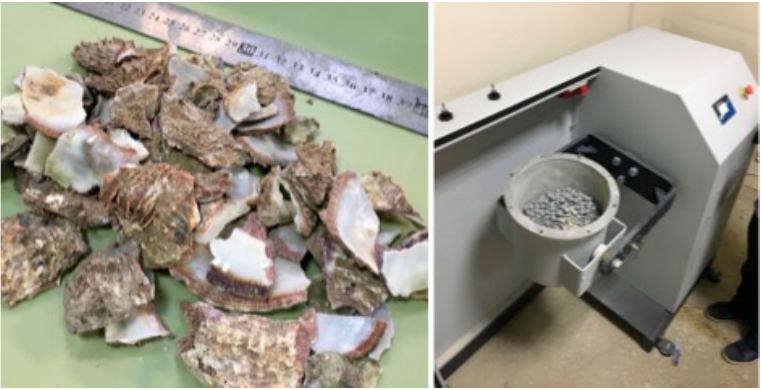
Figure 1. Photo of the waste seashells and grinding mill used. The cement, LF, MK, and seashell chemical and physical properties are summarized in Table 1, while their particle size distribution curves determined using a laser diffraction analyzer are plotted in Figure 2. As shown, the MK is essentially composed of SiO 2 and Al 2 O 3 compounds (i.e., 55% and 39%, respectively), making it excellent aluminosilicate precursor for producing GP mortars. On the contrary, the seashell materials contain about 54% calcium carbonate, reflecting its inert nature just like the limestone fillers. The MK material is extremely fine, having a B.E.T value of 19,000 m 2 /kg, while the Blaine fineness for LF and seashell was 360 and 345 m 2 /kg, respectively. Table 1. Chemical and physical properties of cement, LF, MK, and